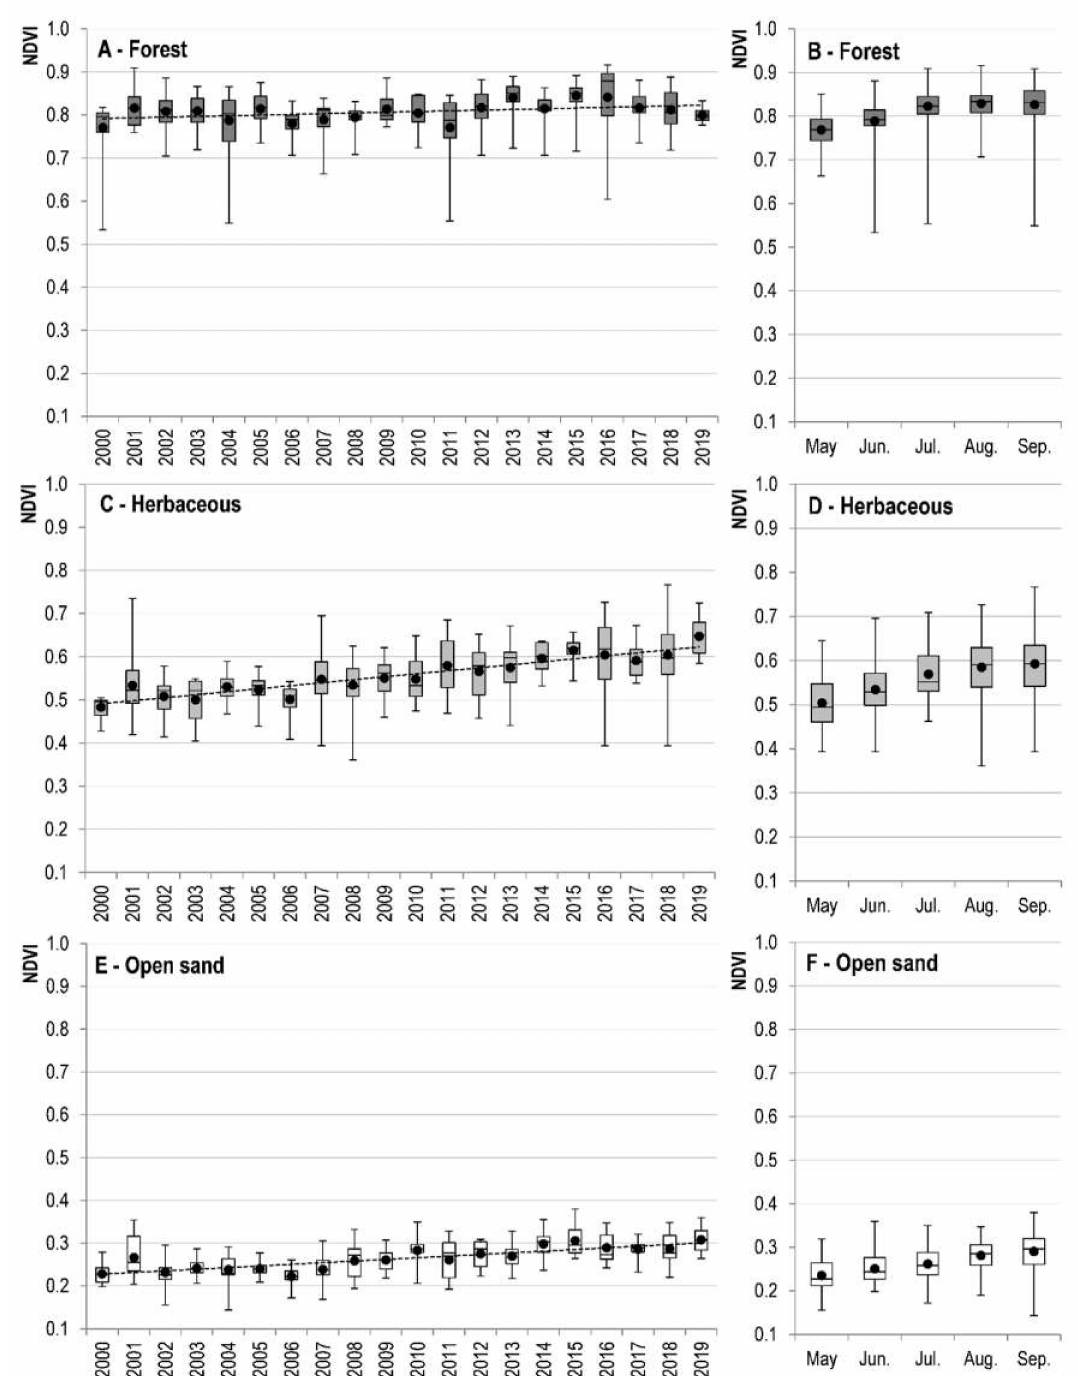
Figure 2. Average annual ( A , C , E ) and average monthly ( B , D , F ) NDVI box plots during growing seasons (May–September) in 2000–2019. The lower and upper hinges correspond to the first and the third quartiles, upper and lower whiskers correspond to maximum and minimum